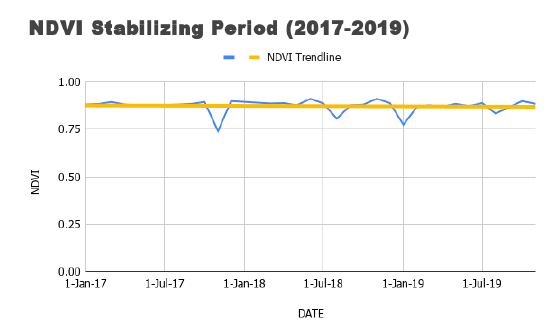
Figure 7. 2017-2019 NDVI Time Series Chart (Stabilizing